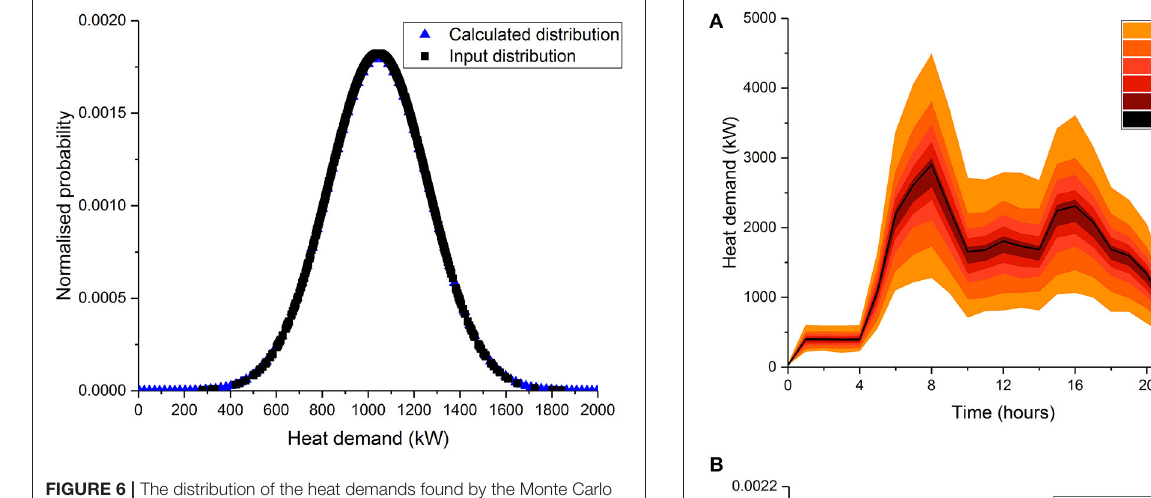
FIGURE 6 | The distribution of the heat demands found by the Monte Carlo simulations of the assumption of an average heat demand profile (2) compared against the distribution of heat demand variations found in the literature, which were used as the inputs into the Monte Carlo simulations.